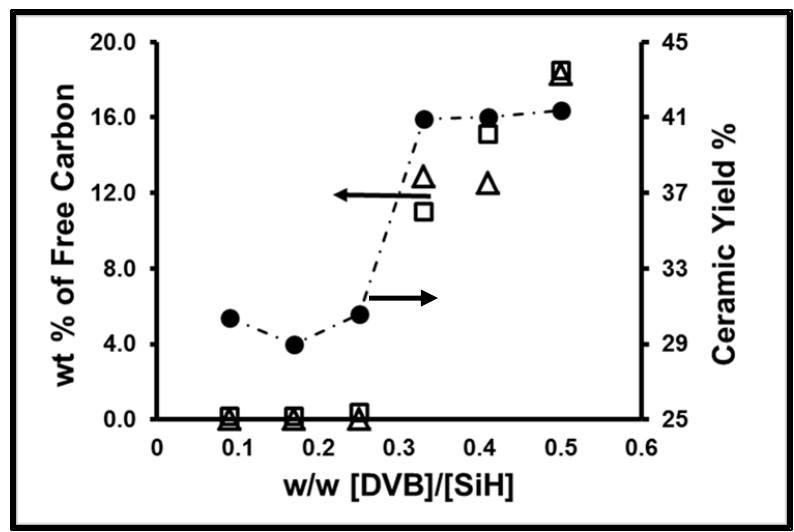
Figure 4. Effect of DVB proportion on free carbon content from (∆) elemental analysis and ( □ ) TGA weight loss and ( • ) ceramic yield of ceramic microspheres. Table 3. Results of Raman studies of SiC/C f